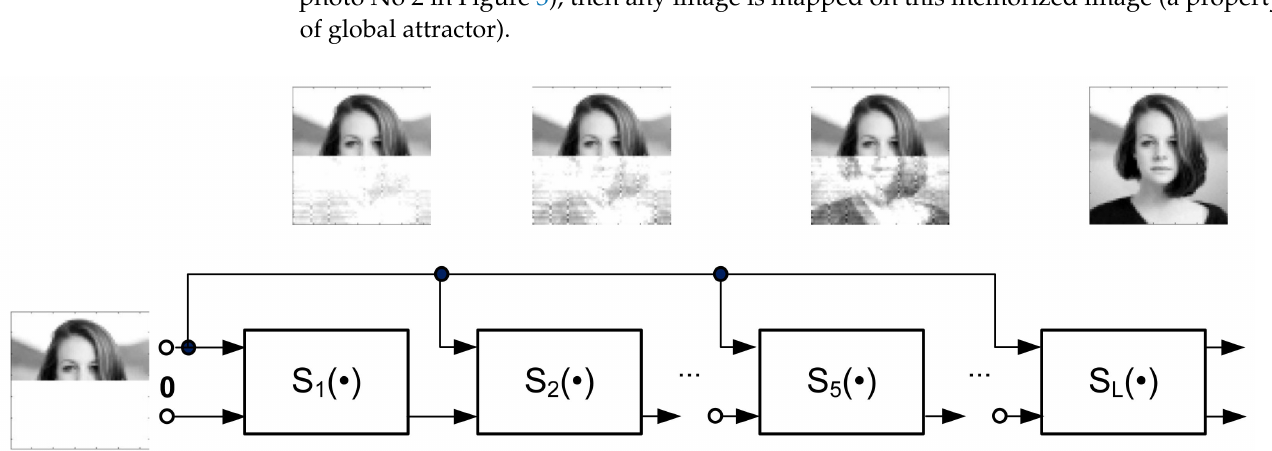
Figure 16. Multilayer learning structure (L—number of steps; e.g., L = 100).